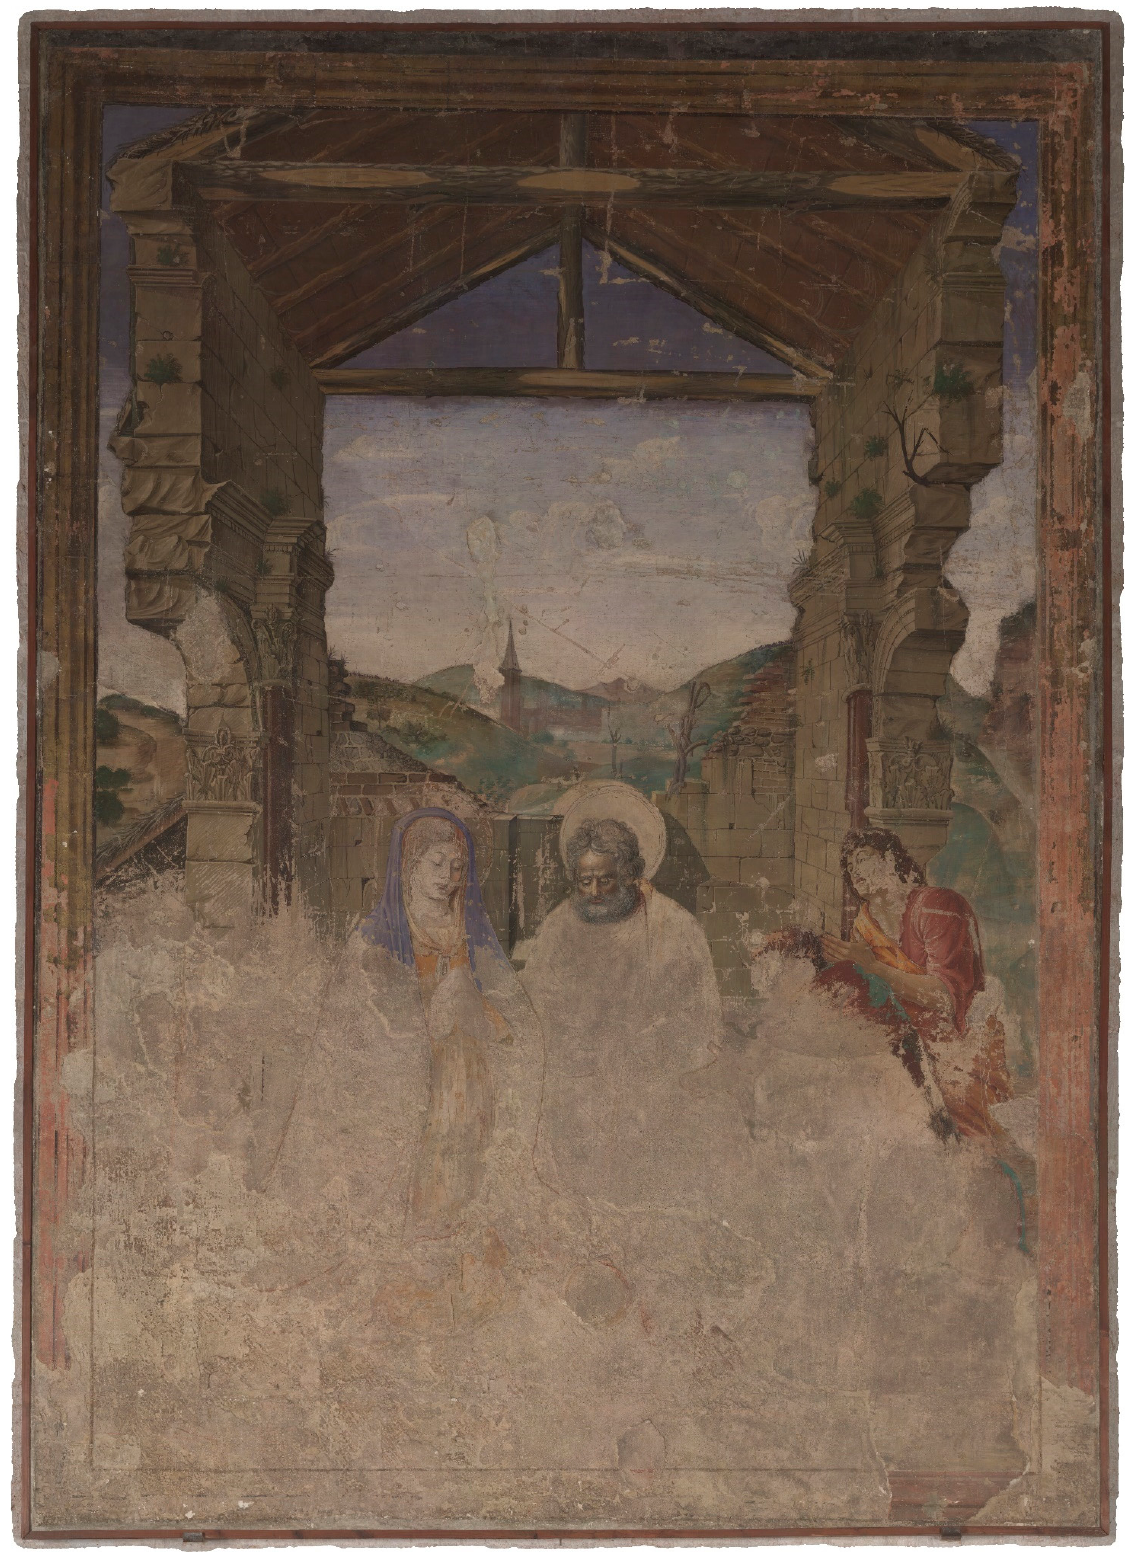
Figure 1. Overview of the “Adoration of the Shepherds” by Paolo de San Leocadio and Francesco Pagano (1472).